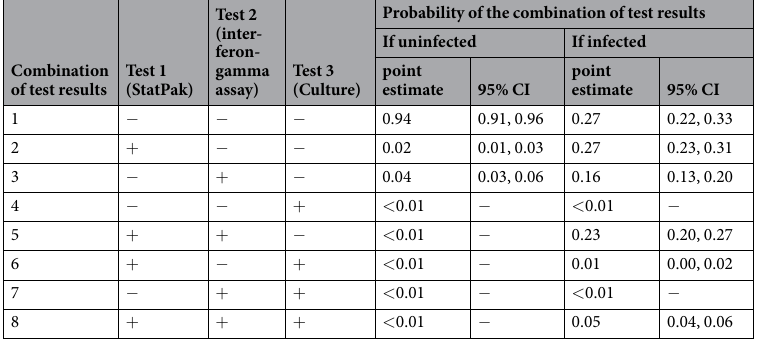
Table 2. Probability of observing each combination of diagnostic test results given the true epidemiological status as uninfected or infected. CI = confidence interval; + = positive test result; −= negative test